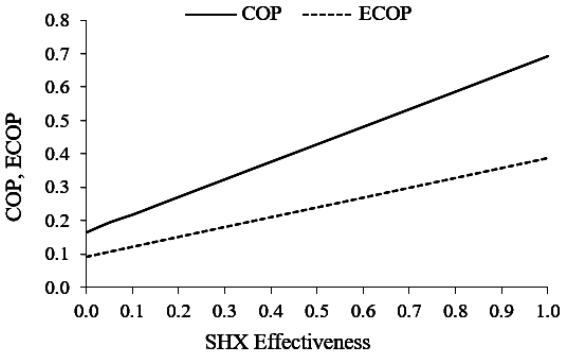
Figure 29. Effect of ε SHX on COP and ECOP.